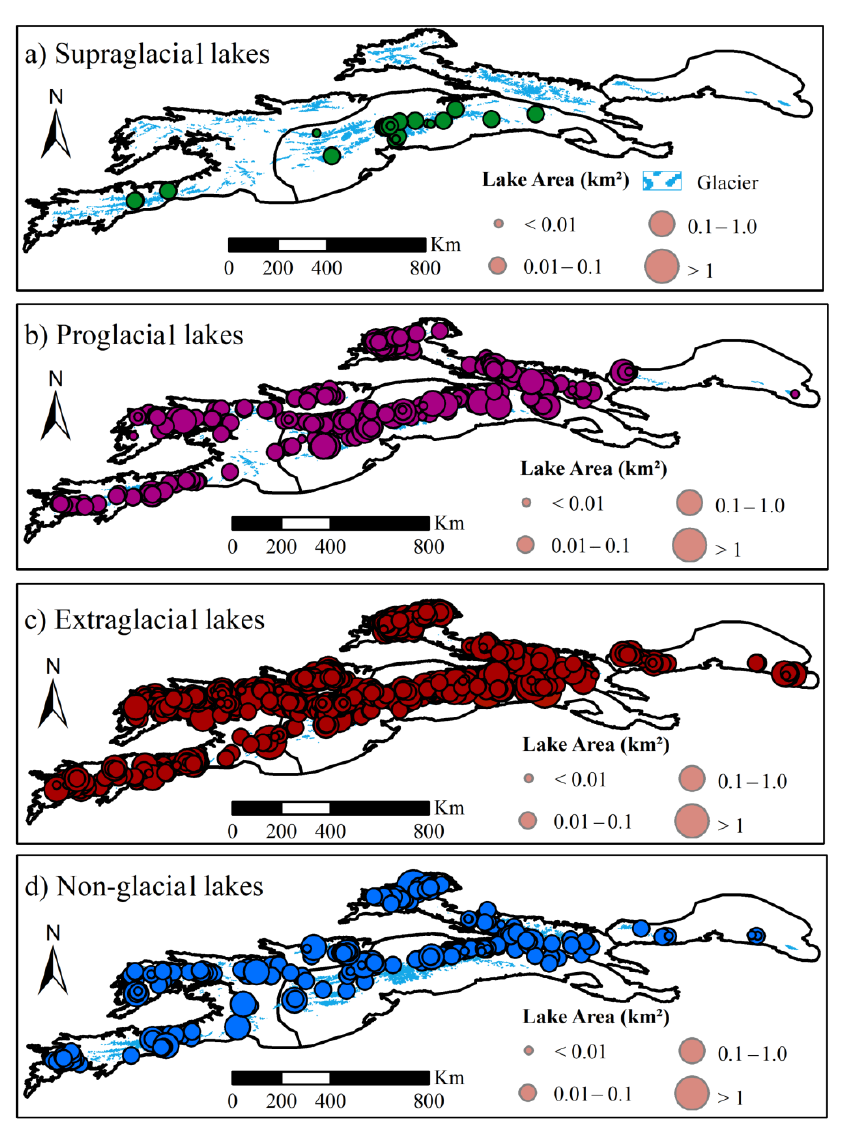
Figure 4. Distribution of the four alpine lake types of different sizes in the TS in 2015. The change rates for the various alpine lake types are shown in Figure 5. Both the number and area of proglacial lakes from 1990 to 2015 exhibited the highest increase with rates of 4.40%/a and 2.41%/a, respectively. Increases in extraglacial lakes and non-glacial lakes followed. In the case of extraglacial lakes, their rates of increase in number and area were 1.48%/a and 0.84%/a between 1990 and 2015, respectively. The increase in extrag- lacial lakes was higher than those for non-glacial lakes, increasing at rates of 0.96%/a and 0.76%/a in 1990 and 2015. It is noteworthy that both the number and area of supraglacial lakes decreased at rates of −0.08%/a and −0.15%/a, respectively.